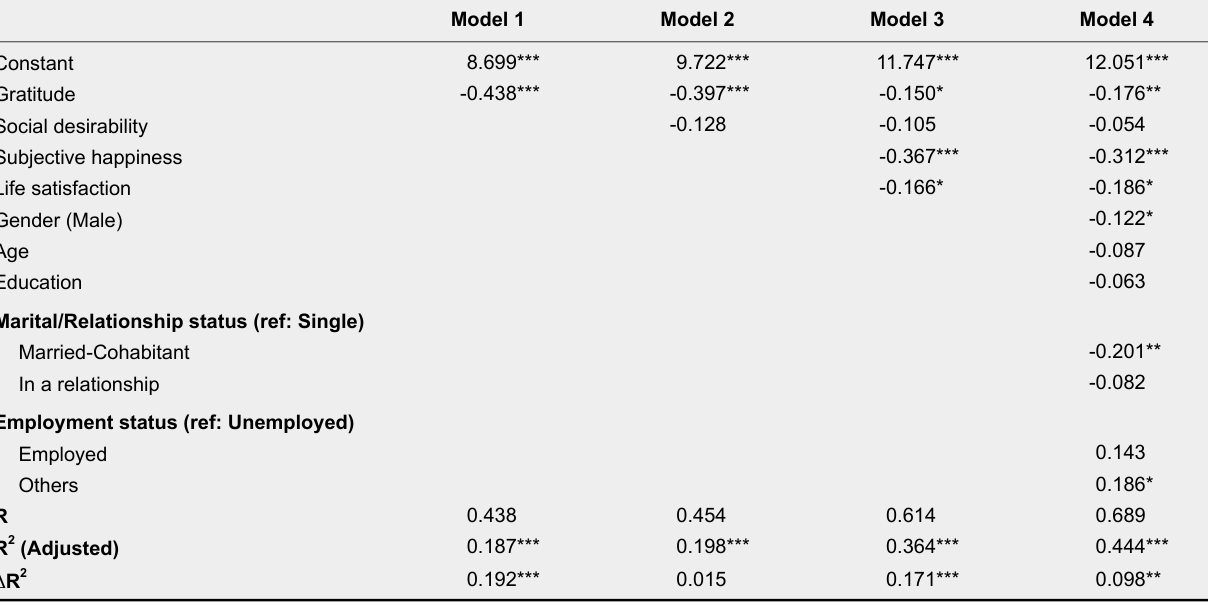
Summary of Hierarchical Multiple Regression Analyses for Predicting Loneliness (Standardized